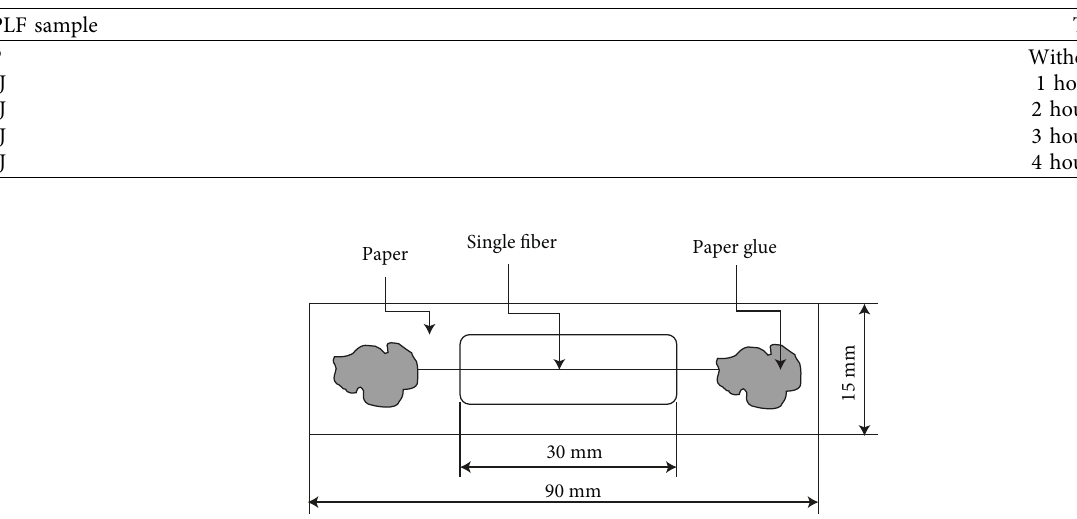
Table 1: King pineapple leaf fiber sample group name [15].